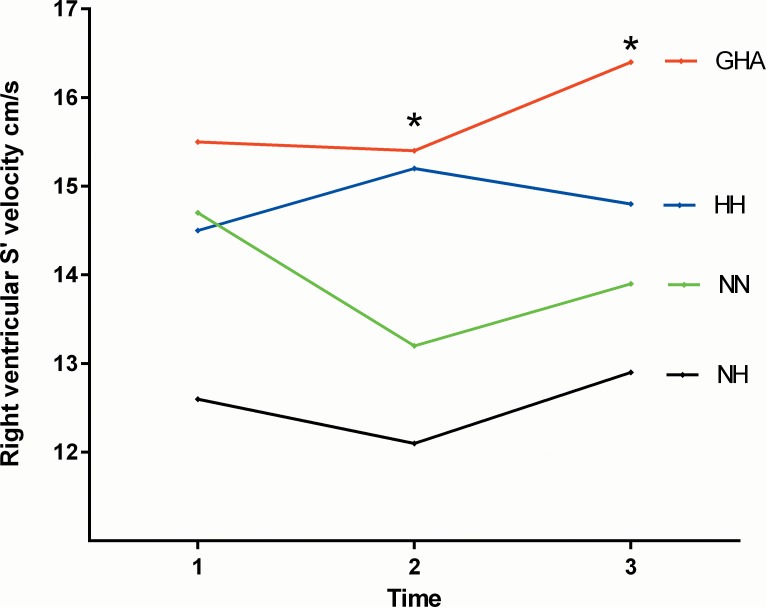
Changes in the right ventricular S’ velocities (marginal means) with differing experimental conditions and duration of hypoxia (time 1 = baseline rest, time 2 = 15 minutes post exercise and time 3 = 120 minutes post exercise).* demonstrates between group differences on post test.